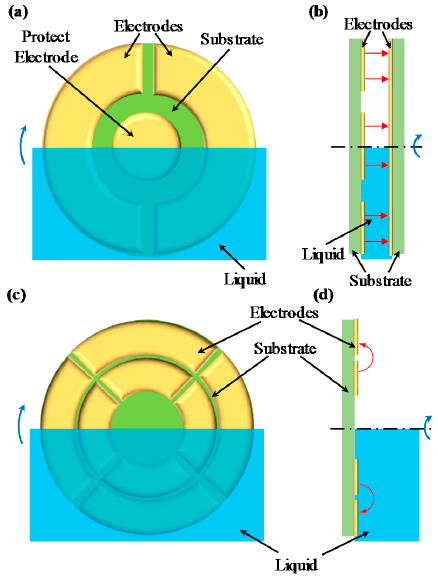
Figure 1. Schematic views of capacitive tilt sensors using parallel electrodes: ( a ) front view and ( b ) side view; schematic views of capacitive tilt sensors using annular coplanar electrodes: ( c ) front view and ( d ) side view.